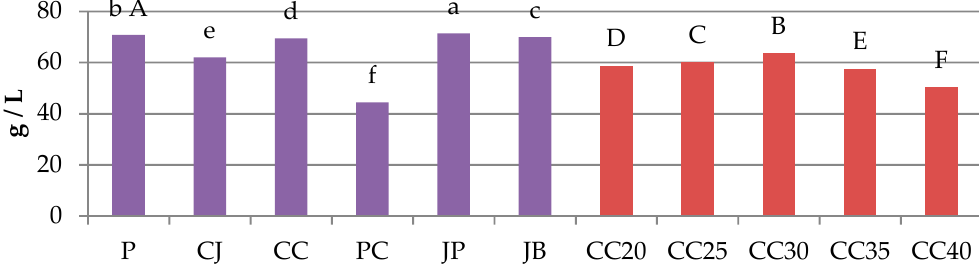
Figure 2. Content of fermentable sugars (glucose, maltose, maltotriose) in wort. Values are expressed as sums of the means of 3 replications ( n = 3) for the fermentable sugars tested (glucose, maltose, maltotriose). Mean values with different letters (a, b, c, d, e, f or A, B, C, D, E, F) are statistically different ( p -value < 0.05).